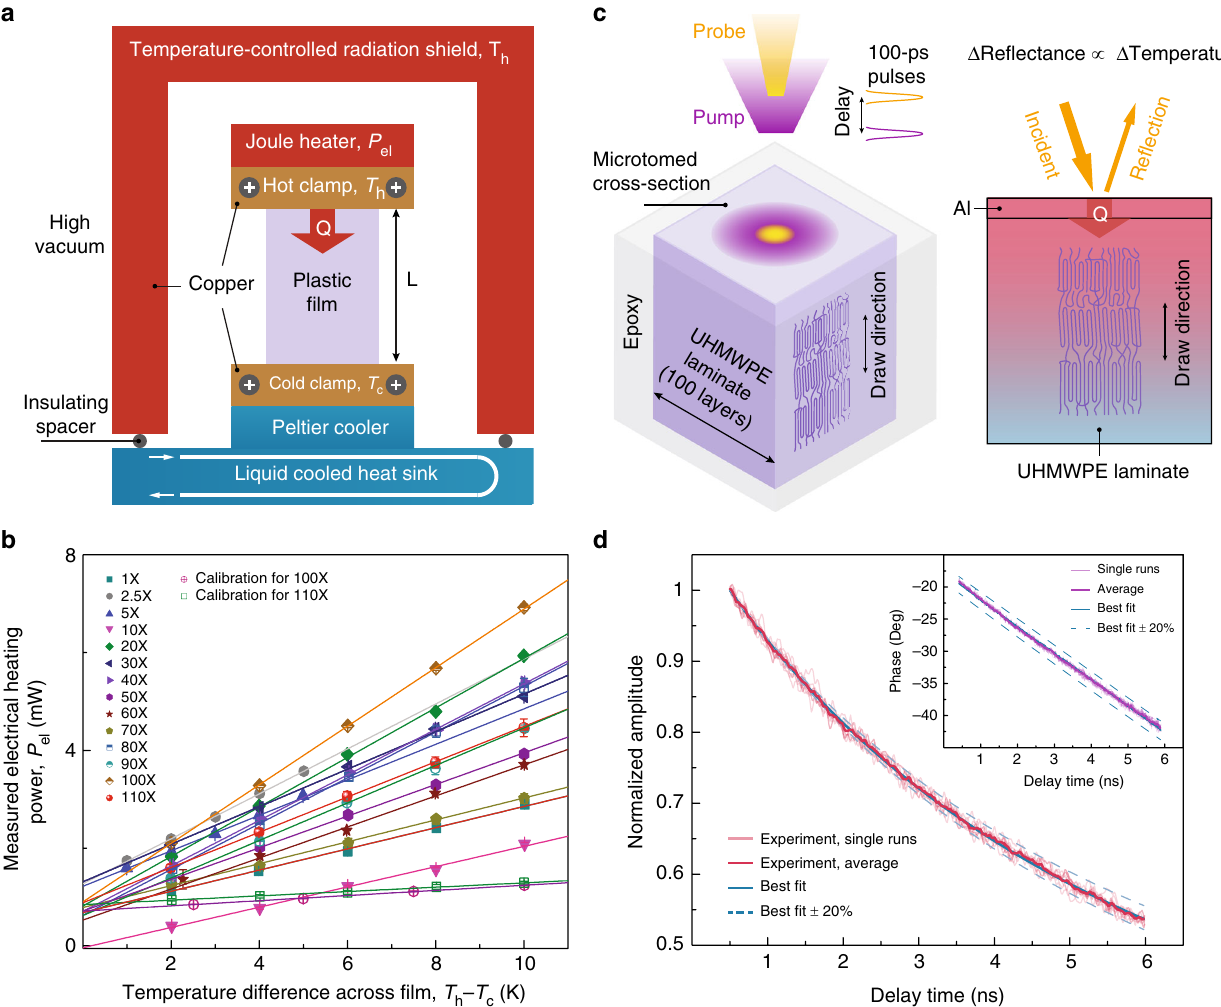
Fig. 2 Measurement of heat transport along the draw direction of the polymer fi lms. a Schematic of the home-built steady-state thermal conductivity measurement system. A small temperature difference ( T h − T c ) across a fi lm sample is created and maintained using Joule heating (electrical heating power, P el , see Supplementary Note 2 and Supplementary Fig. 1c, d for more details) and thermoelectric cooling inside a high vacuum chamber (Supplementary Fig. 1). b Measured electrical heating power ( P el ) as a function of the temperature difference ( T h − T c ) across fi lms. The error bars represent the maximum and minimum electrical heater power values measured over the course of 1 min at a sampling rate of 1 Hz. (Supplementary Note 2 and Supplementary Fig. 1b, c). c Illustration of the two-color time-domain thermore fl ectance measurement scheme. An aluminum-coated UHMWPE laminate is fi rst heated with a 100-fs-wide pump laser pulse (400 nm, purple) and subsequently monitored with a time-delayed low-power probe pulse (800 nm, yellow). The change in aluminum re fl ectance is proportional to surface temperature variation in the linear regime. d Ten individual cooling curves in terms of signal amplitude (light red lines), overlaid with their average (thick red) and the best fi t curve (blue solid) that yields a thermal conductivity of 31.9 Wm − 1 K − 1 . Changing the best fi t by 20% leads to large discrepancies between the simulated (blue dashed) and measured curves. Inset shows the corresponding phase signals, fi tting to which yields a thermal conductivity of 32.8 Wm − 1 K − 1 (Supplementary Note